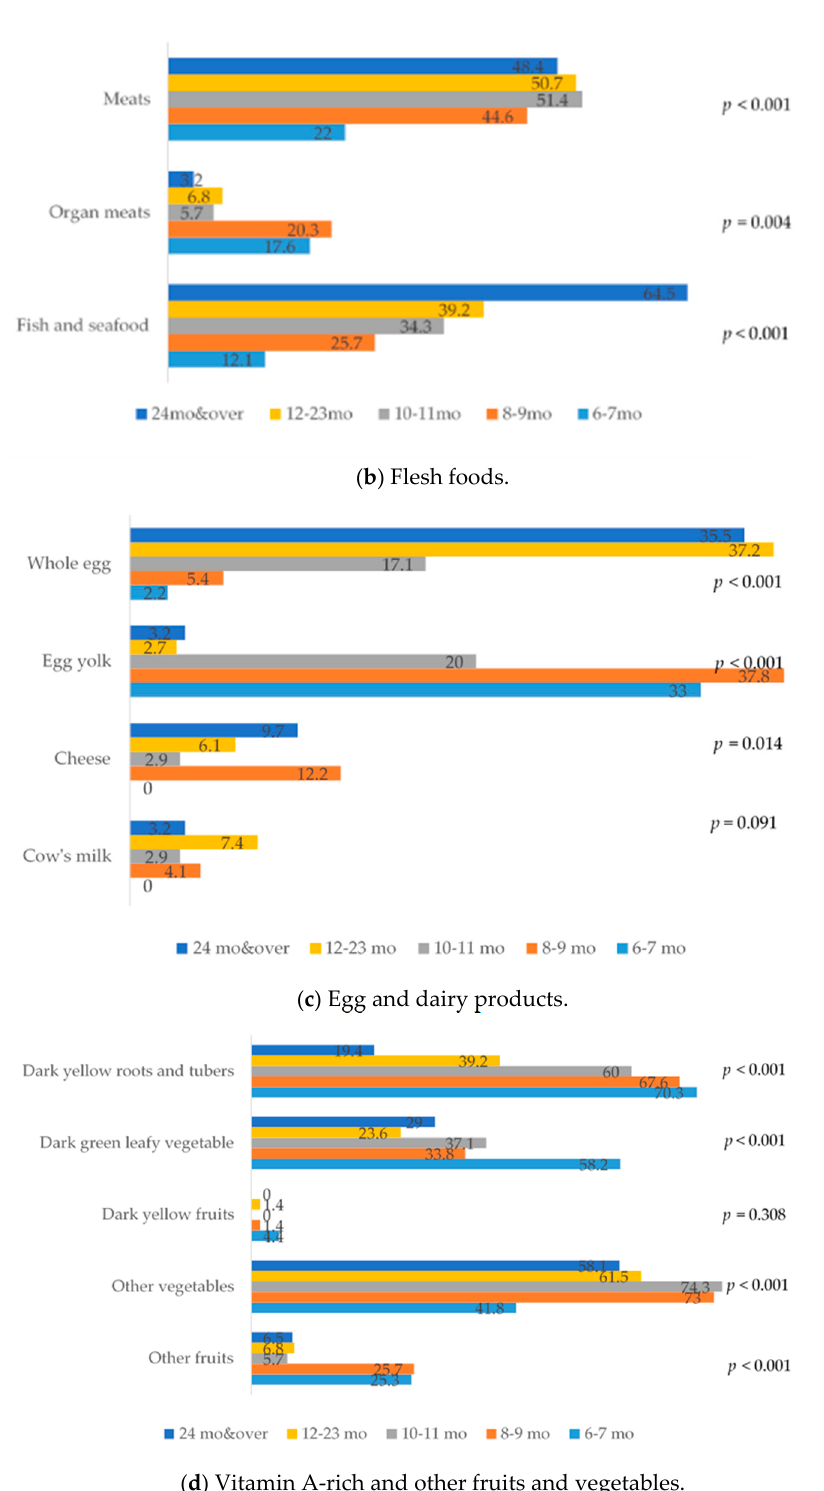
Figure 2. Percentage of ingredients used in shared recipes across children’s age groups.